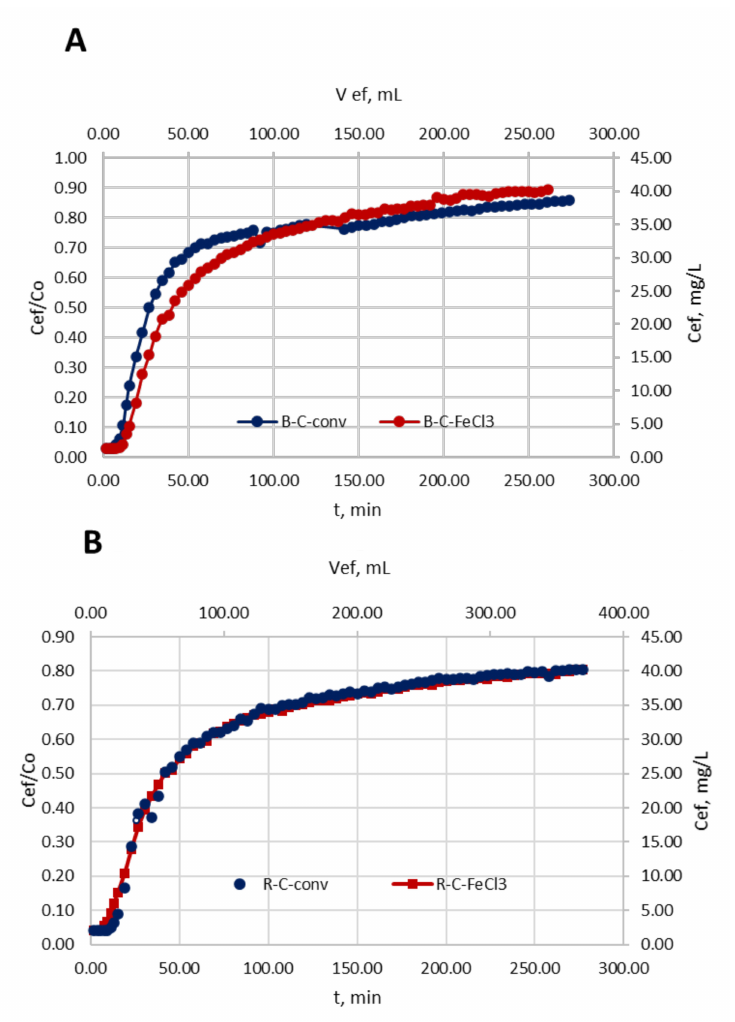
Figure 7. Observed breakthrough curve stains on C -conv and C - FeCl presented. ( A ) Bordeaux B and ( B ) Red